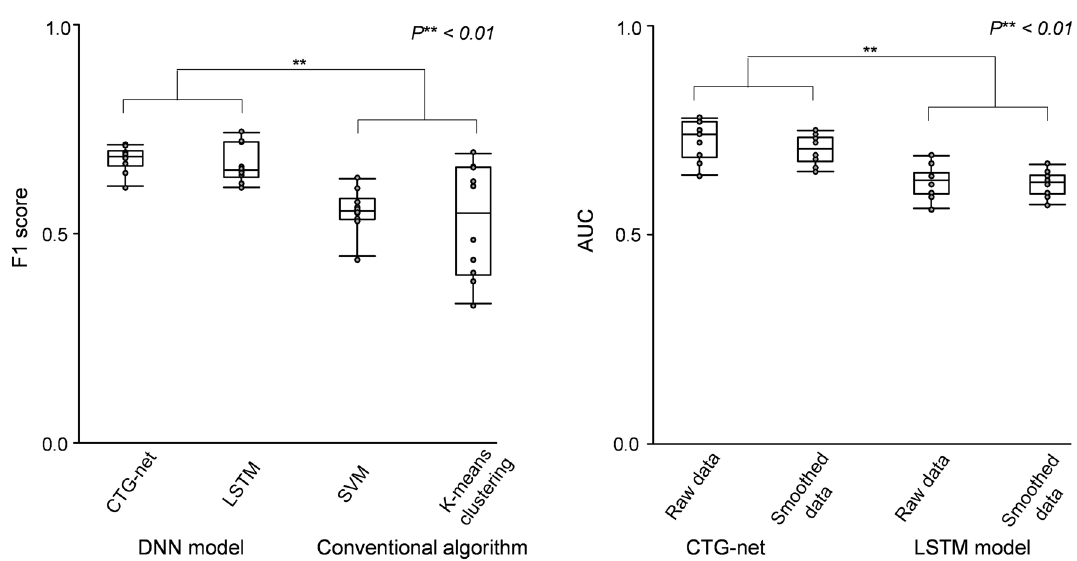
Figure 4. ( A ) F1 score of CTG-net, LSTM-based model, SVM, and k-means clustering. ( B ) ROC-AUC of the CTG-net and LSTM-based models trained with raw data or smoothed